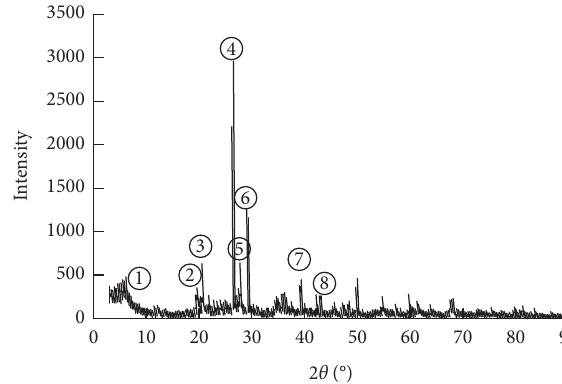
Figure 4: The experimental map of